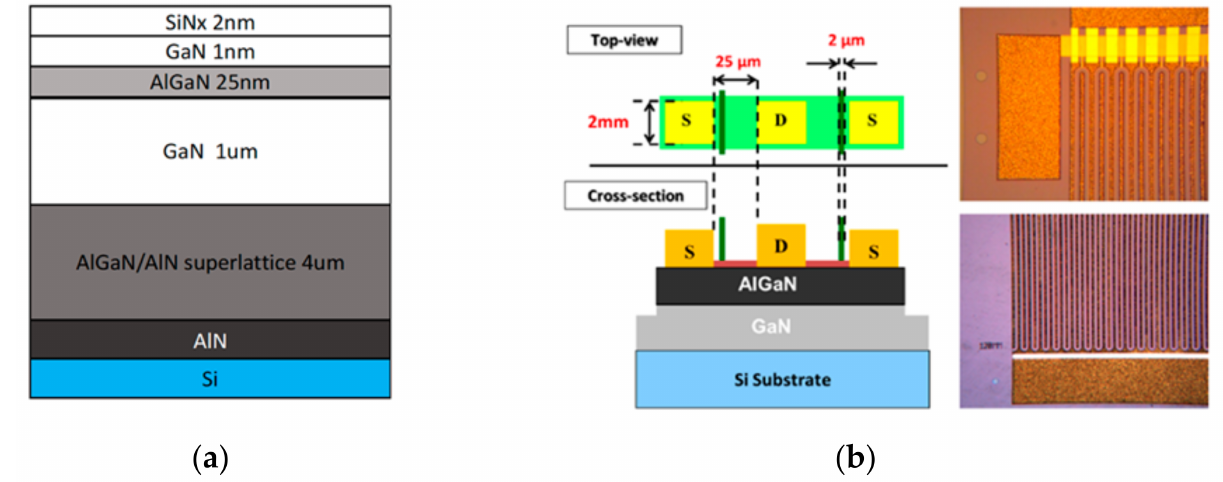
Figure 1. ( a ) Cross-section of the D-mode GaN MIS-HEMT; ( b ) 120 mm D-mode GaN MIS-HEMT devices.